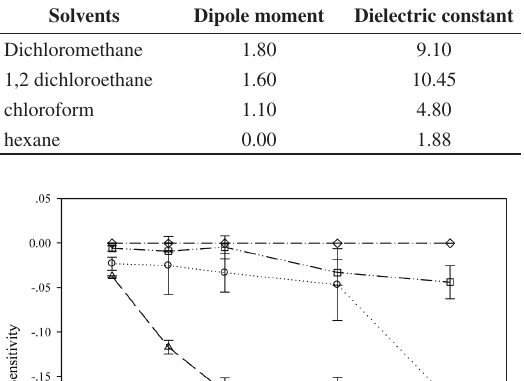
Table 4. Values of dielectric constant ( ε ), dipole moment (µ) of the solvent tested 29 .